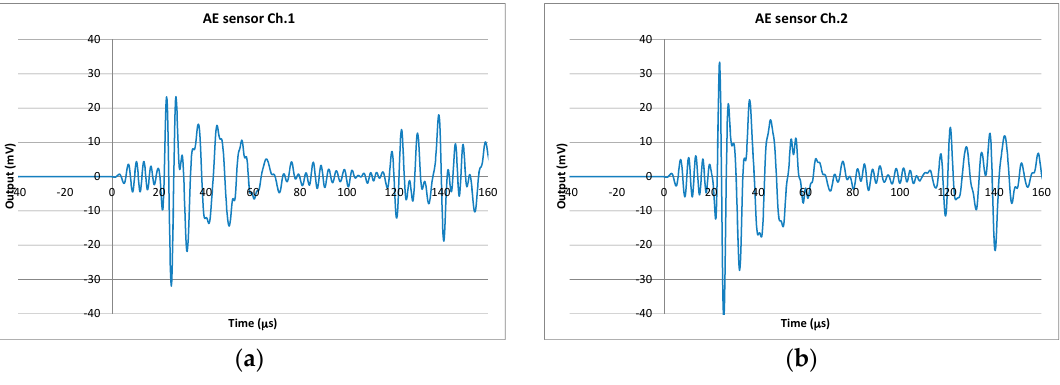
Figure 6. Waveform of AE sensor ( a ) ch.1 and ( b ) ch.2.